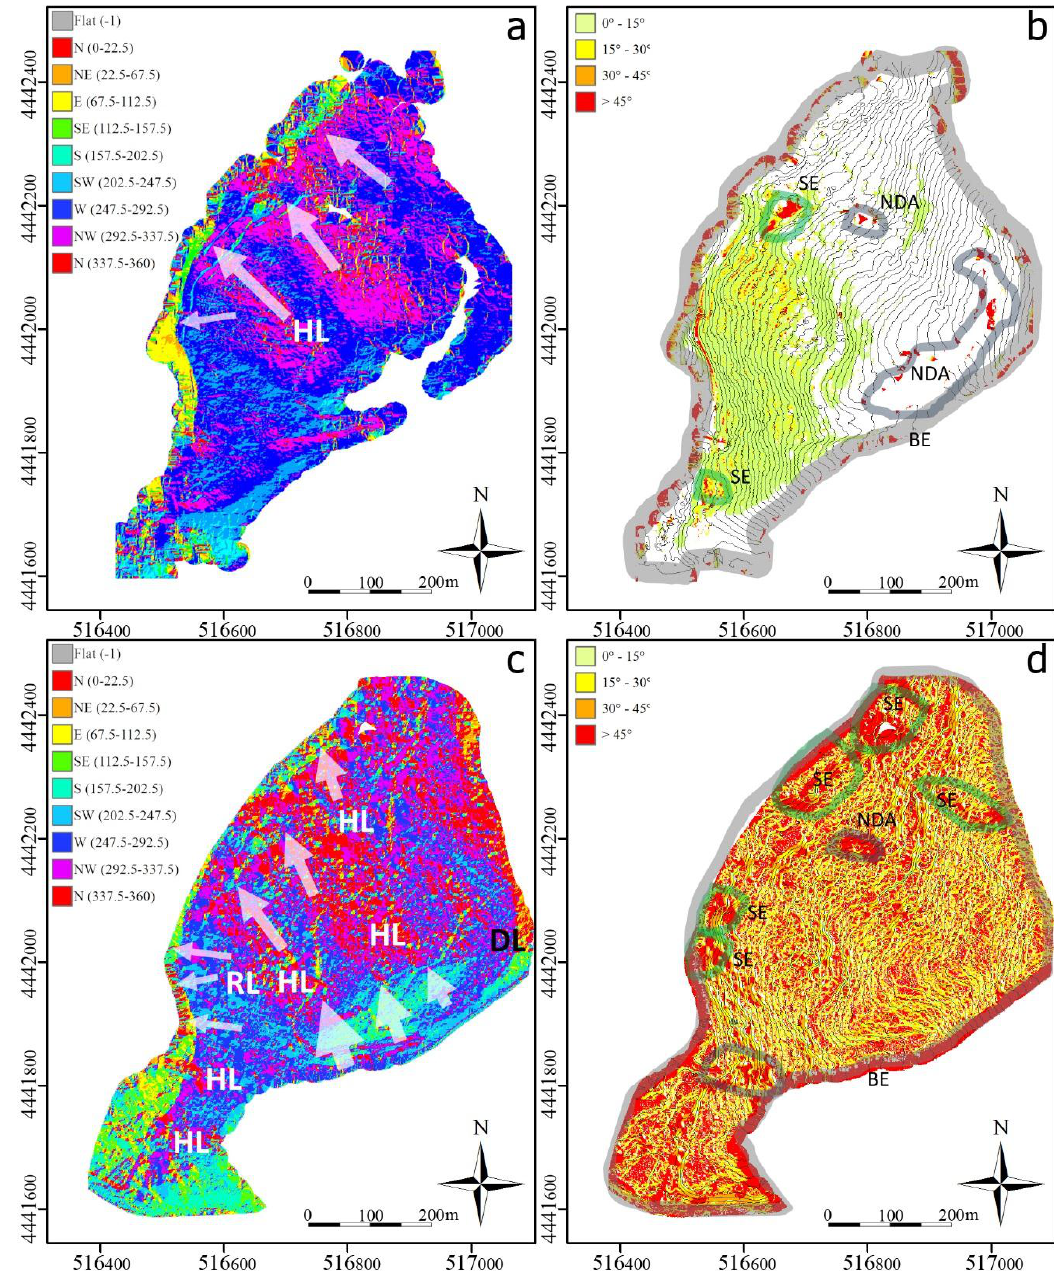
Figure 10. ( a ) Aspect map using TLS data ( b ) relative standard deviation; ( c ) aspect map using HRSI data; ( d ) relative standard deviation. Legends in ( a ) and ( c ): aspect parameter interpretation: HL Hummocky Landslide body, RL stepped Reactivated Landslide body, DL Degraded head and lateral Landslide scarps. White arrows highlight the main directions of the deep, intermediate and shallow failure plane movements. On the maps of uncertainty ( b , d ), coding of the more probable origin of the errors is added: BE = boundary effect, NDA = non-instrumentally detected area, SE = shadow effect.